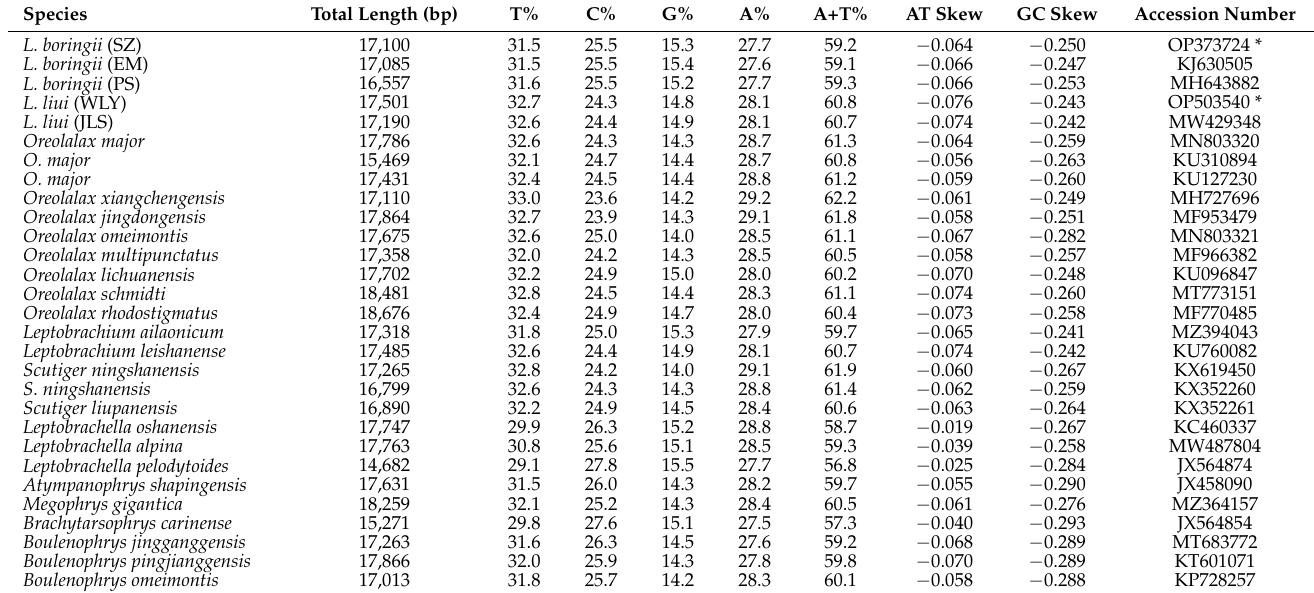
Table 2. Base composition (in percentages) of the mitogenomes of three populations of L. boringii , two populations of L. liui, and another 21 species in Megophryidae.